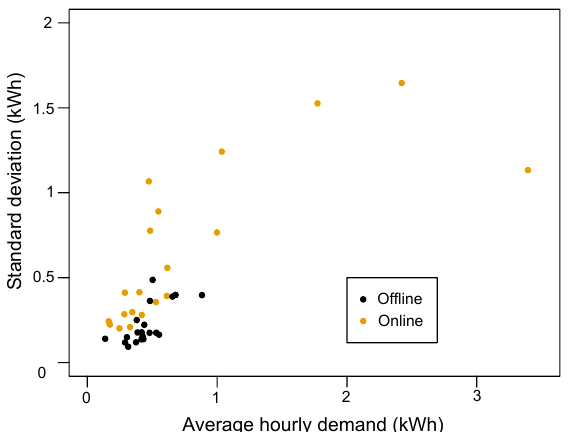
Figure 8. Characteristics of the individual time series of the 20 households in the offline (black points) and online (orange points) cases. The standard deviation of the series ( y -axis) is represented in regard with its mean hourly demand ( x